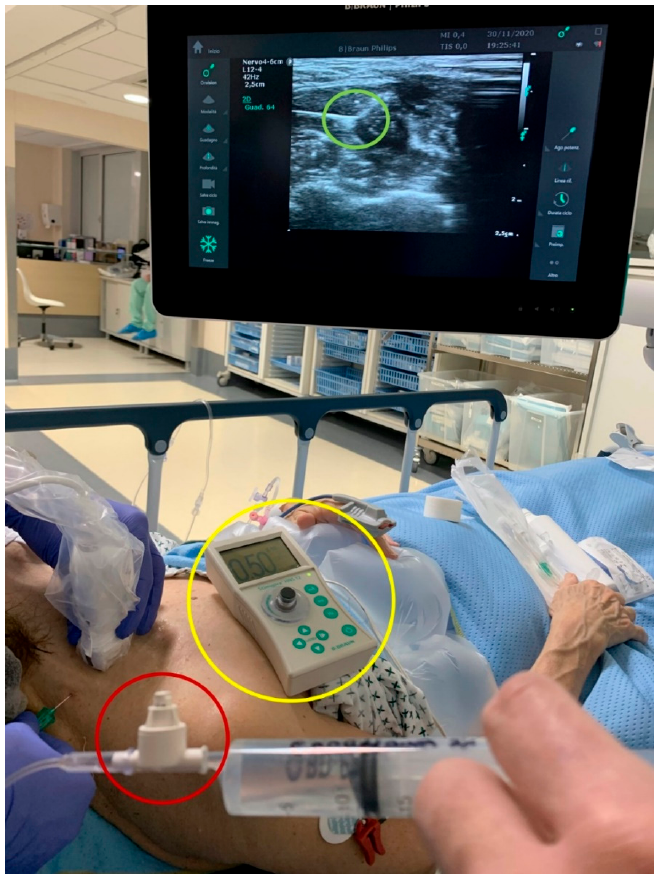
Figure 2. The triple monitoring devices. Green circle: ultrasound guidance; yellow circle: nerve stimulator; red circle: opening injection pressure monitoring device (BSmart ® ).